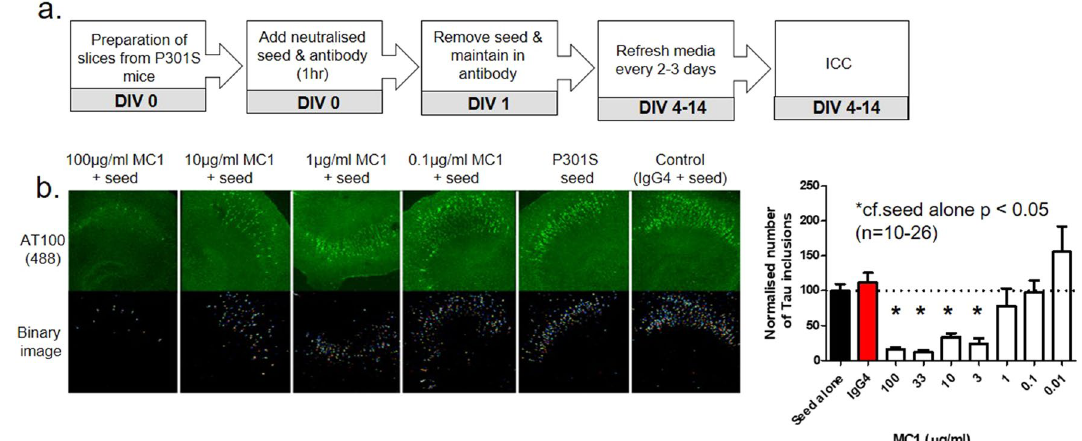
Figure 5. The MC1 antibody reduces AT100 + tau in a concentration-dependent manner. ( a ) Experimental paradigm of antibody neutralisation of P301S seed. ( b ) The MC1 antibody had the ability to reduce AT100 + tau inclusions in a concentration dependent manner as shown via immunocytochemistry (ICC). Statistics: Groupwise comparison, one-way ANOVA with Dunnett’s post hoc test; *, P <